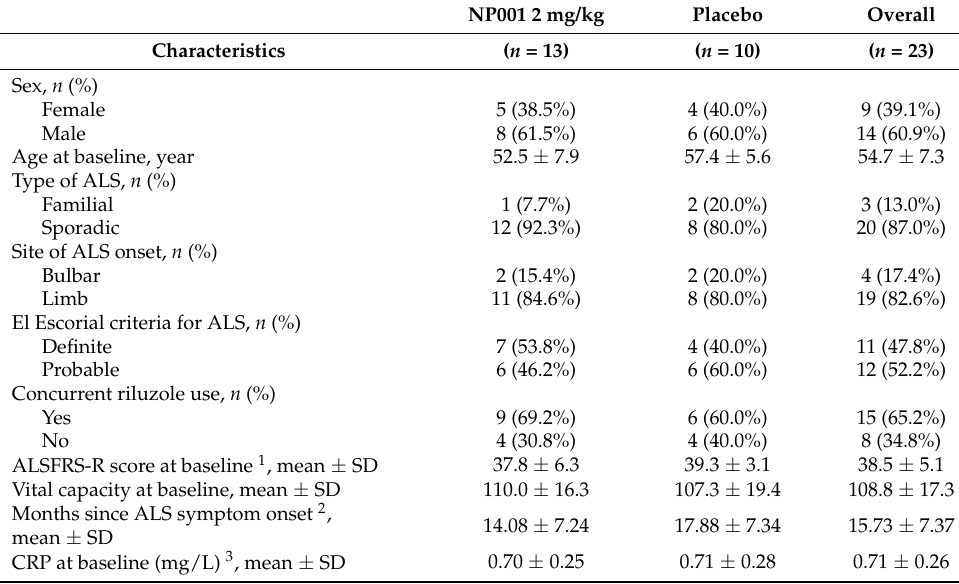
Table 3. Baseline demographics and characteristics of participants treated with NP001 vs. placebo in those with age between 40 and 65 years old and plasma CRP < 1.13